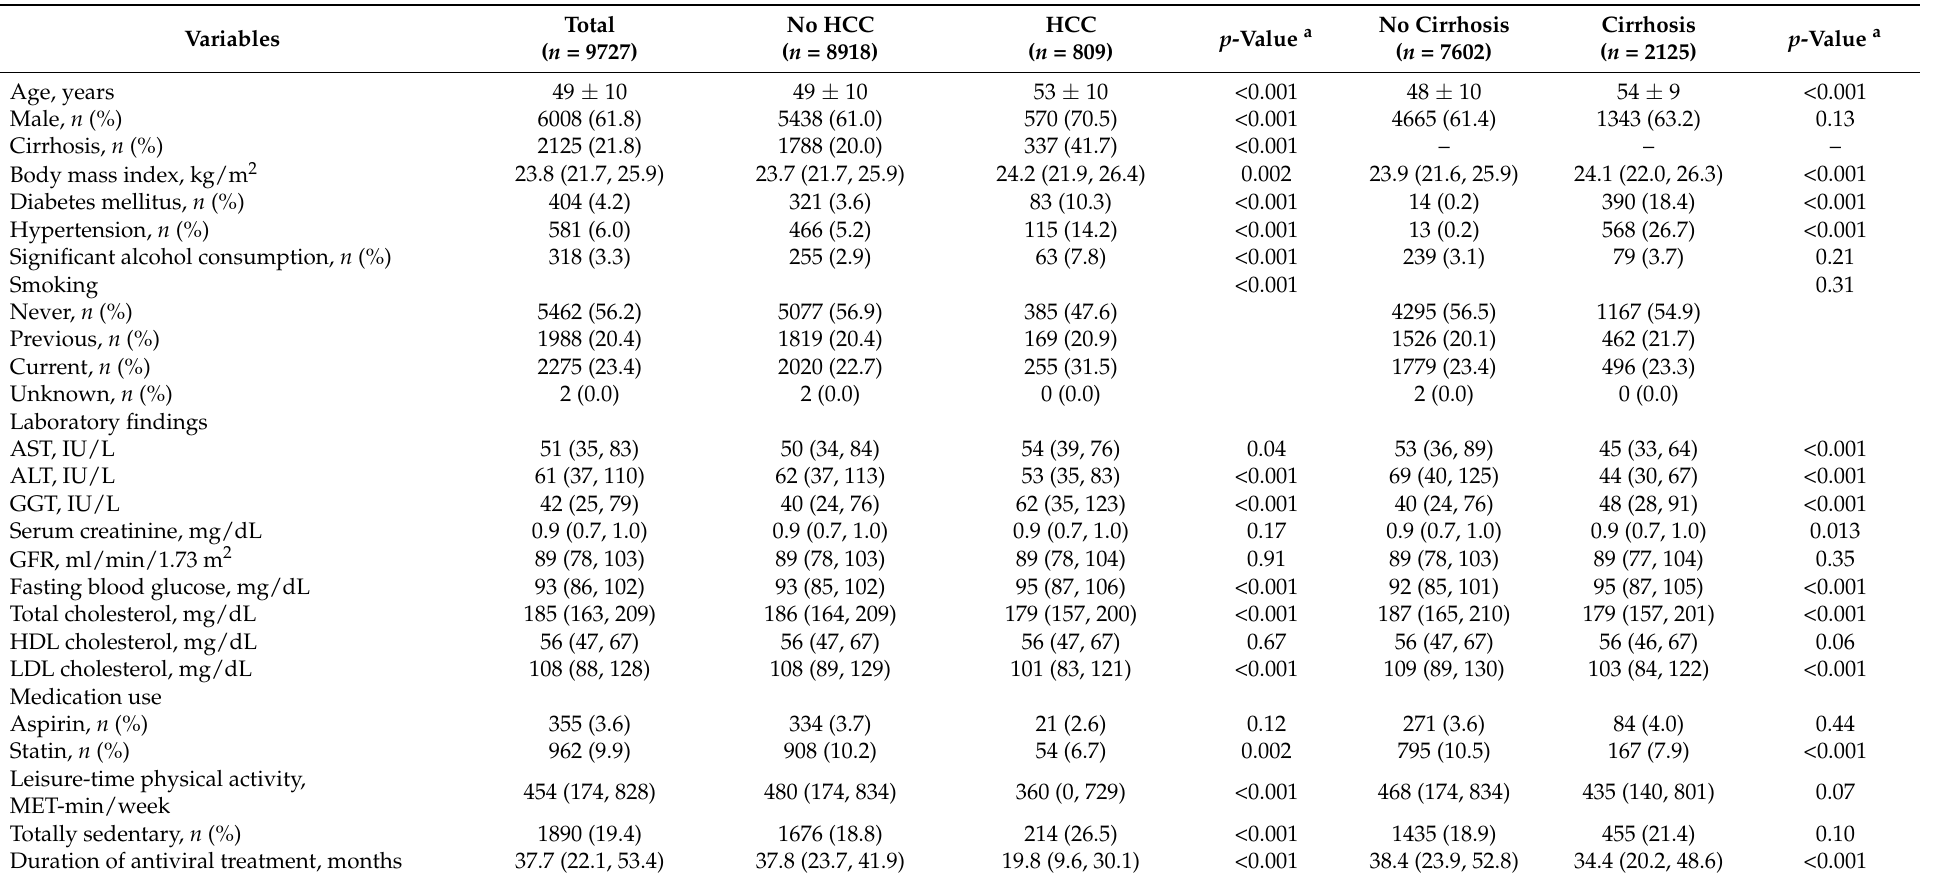
Table 1. Baseline characteristics of the total study